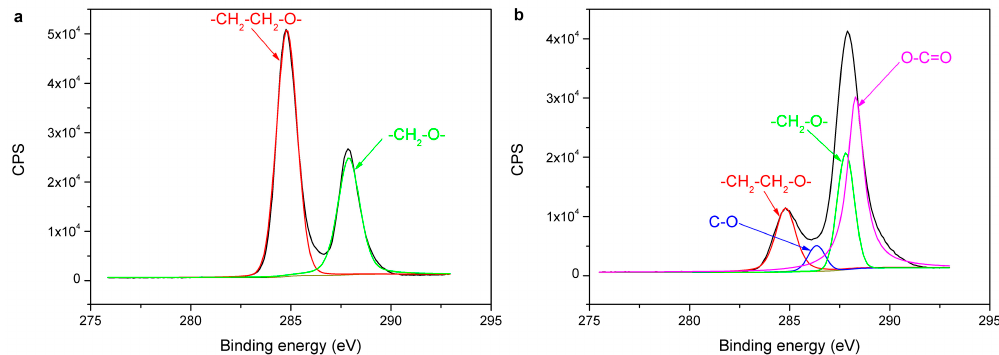
Figure 11. C1s spectra of polymer surface: ( a ) untreated POM; ( b ) treated POM. Table 5. Percent peak area of XPS C1s spectra of untreated and treated PE and POM. Untreated (at %) Treated (at %) Untreated (at %) Treated (at %) Possible Functional